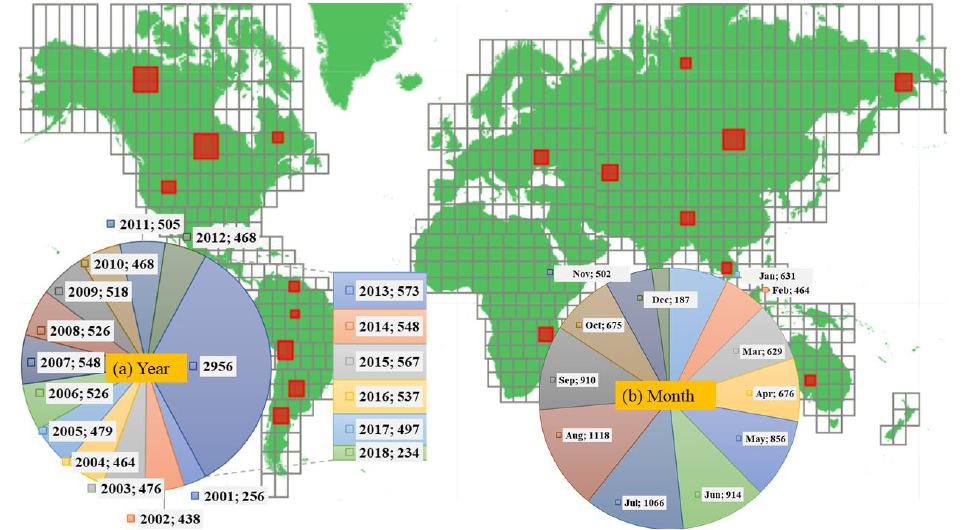
Figure 4. Division of the global land (gray boxes were used for global surface water mapping), validation regions distribution (red boxes were used for accuracy validation) and number of validation sample points in every year ( a ) and month ( b ).